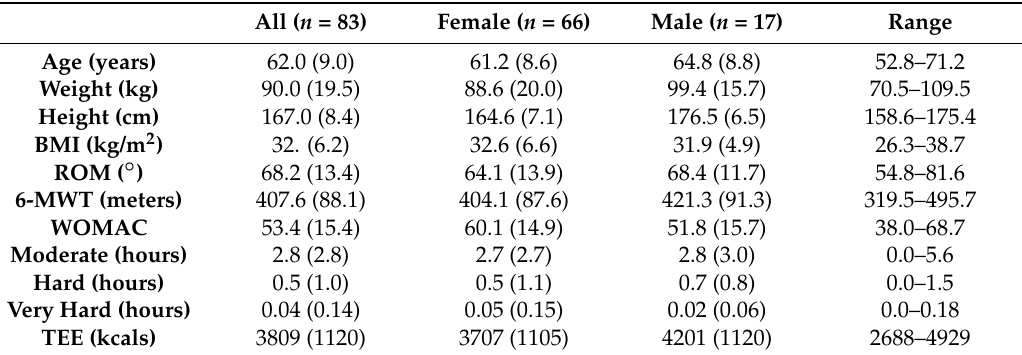
Table 1. Participant characteristics ( n = 83).